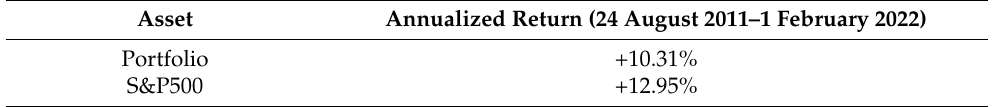
Table 5. Comparison of the annualized portfolio return with the annualized return of the S&P500.